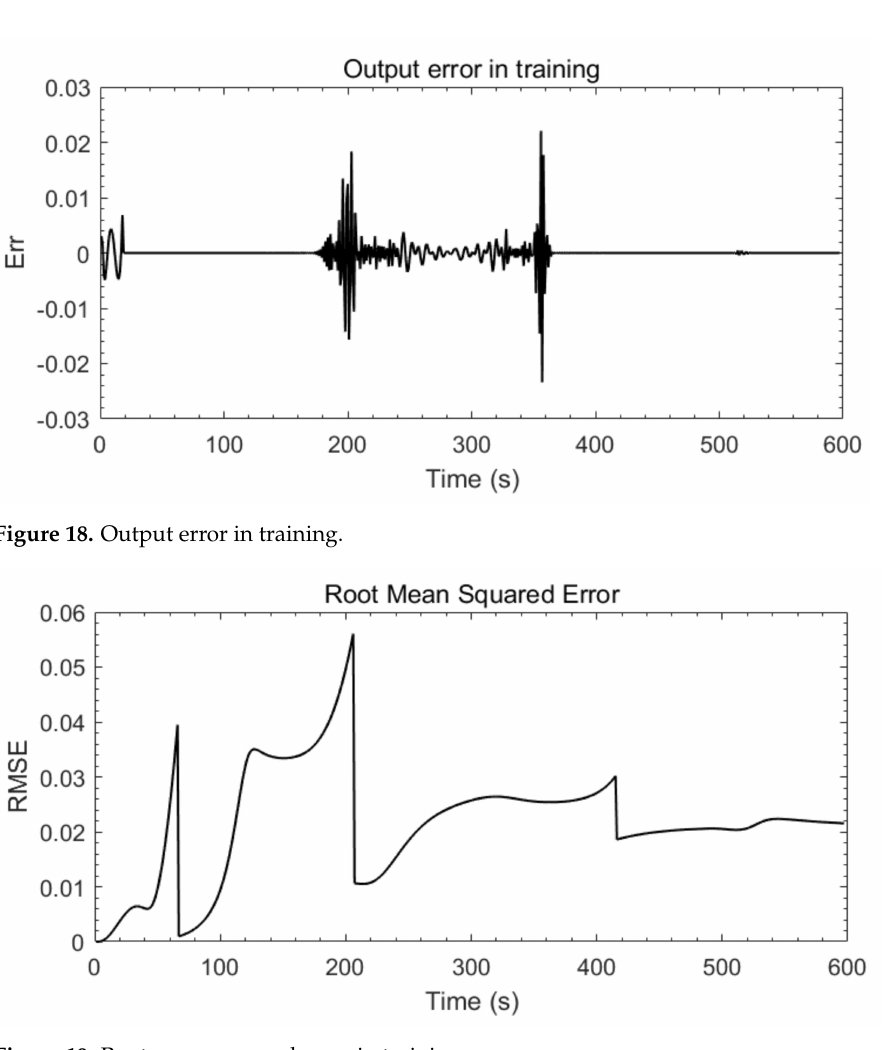
Figure 19. Root-mean-squared error in